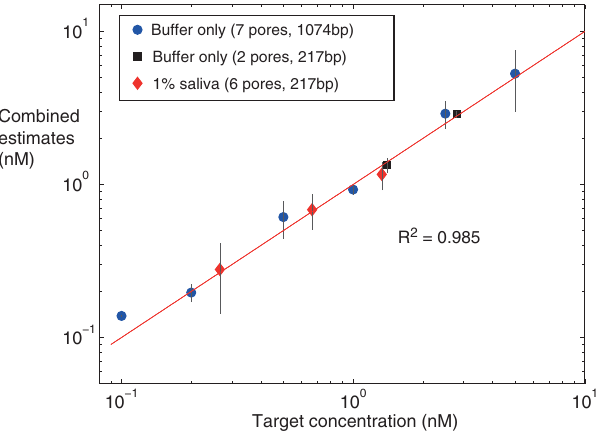
Figure 5. Combining single-nanopore estimates of HGD65 target concentration to gauge accuracy and precision. The combined estimate data plotted at each known target concentration is the average and standard deviation of at least two estimates generated from separate single-nanopore experiments (data in Table 1). The concentrations are above the nanopore after dilution. Single-pore estimates were combined where a common scaffold/fusion reagent was used (7 pores P7-P13, and 2 pores P14-P15) or by the presence of 1% saliva background above the pore (6 pores P21-P26). The R 2 value assesses how closely the average estimates are to the zero error line, with the three-parameter model ( R 2 = 0.985, Supplementary Table S45) outperforming the two- parameter model ( R 2 = 0.953, Supplementary Table S46 and Fig. S24).